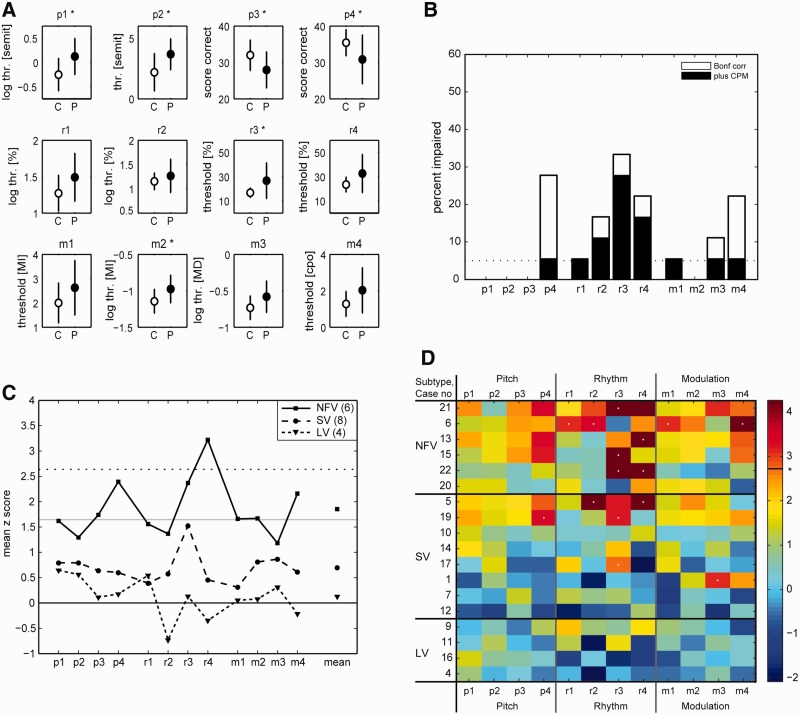

Patients’ psychoacoustic data in comparison to controls. (A) Group comparison of psychoacoustic scores between the PPA group and controls. Asterisks denote a significant difference (P = 0.05, Bonferroni-corrected). (B) Percentage of all PPA patients (n = 18) who exhibited a significant impairment, plotted for each of the 12 tests. White boxes indicate percentage of deficits at the individual deficits (Crawford t-test, Bonferroni-corrected); black boxes indicate the percentage that remains significant after regressing out the effect of Coloured Progressive Matrices (CPM) scores as a measure of fluid intelligence. (C) Mean Z scores across patients within the three clinical subtype groups. Mean Z scores are plotted for each task, and in addition the overall mean across tasks (far right). Grey line corresponds to the uncorrected P of 0.05, the dotted line to the Bonferroni-corrected P of 0.05. (D) All 18 individual patients’ performance in comparison to controls, in the order of severity (measured by the individual mean Z score across tasks) within each clinical subtype. The colour scale reflects the Crawford-based Z scores derived from the modified t-test (line and asterisk indicate Bonferroni-corrected P of 0.05). The deficits that remain significant (Bonferroni-corrected) after adjustment for Coloured Progressive Matrices scores are marked with a light-grey dot at the centre.